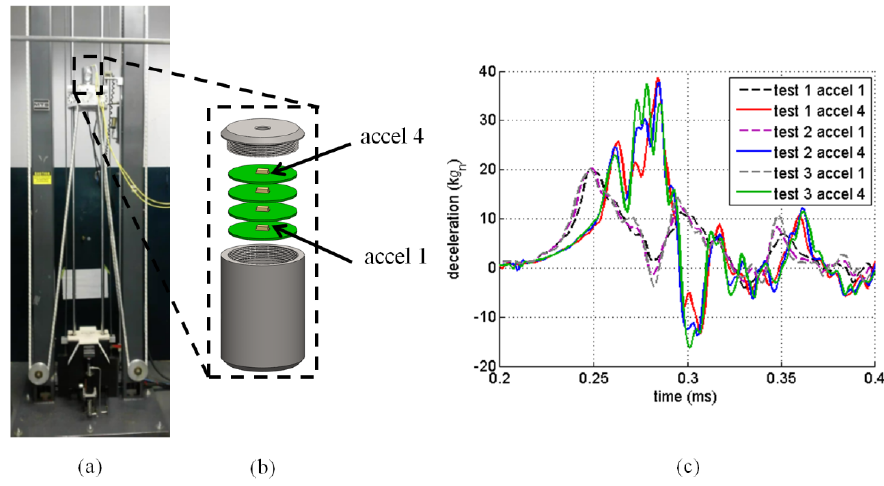
Figure 1. Experimental setup: ( a ) MTS-66 drop tower; ( b ) electronics unit; and ( c ) deceleration from three